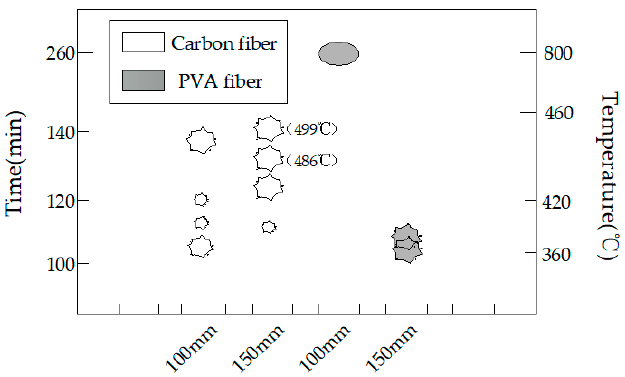
Figure 12. The burst statistics of concrete with different sizes.